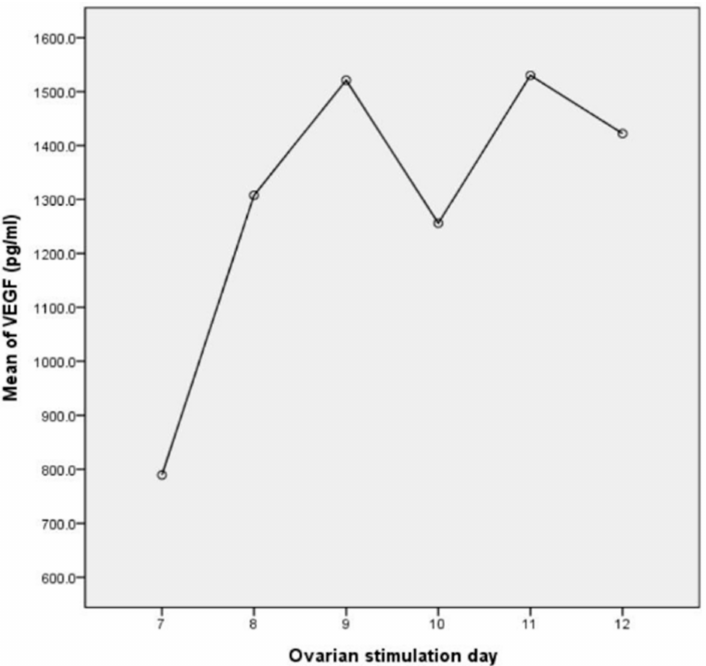
Figure 3. Correlation between intrafollicular VEGF level and number of ovarian-stimulation days. Intrafollicular VEGF secretion was increased with the number of days of ovarian stimulation. The secretion level reached a plateau on stimulation day 9 but then dropped transiently on stimulation day